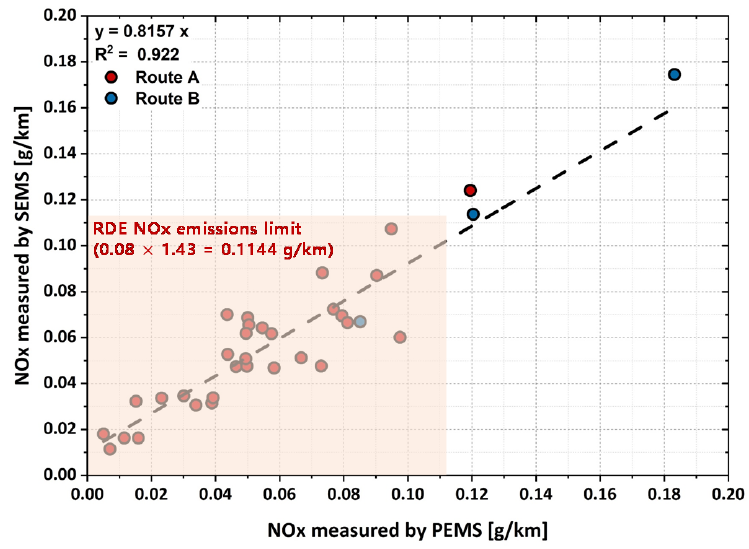
Figure 16. Correlation of NOx emissions measured by the PEMS and SEMS equipment under RDE tests in Routes A and B.